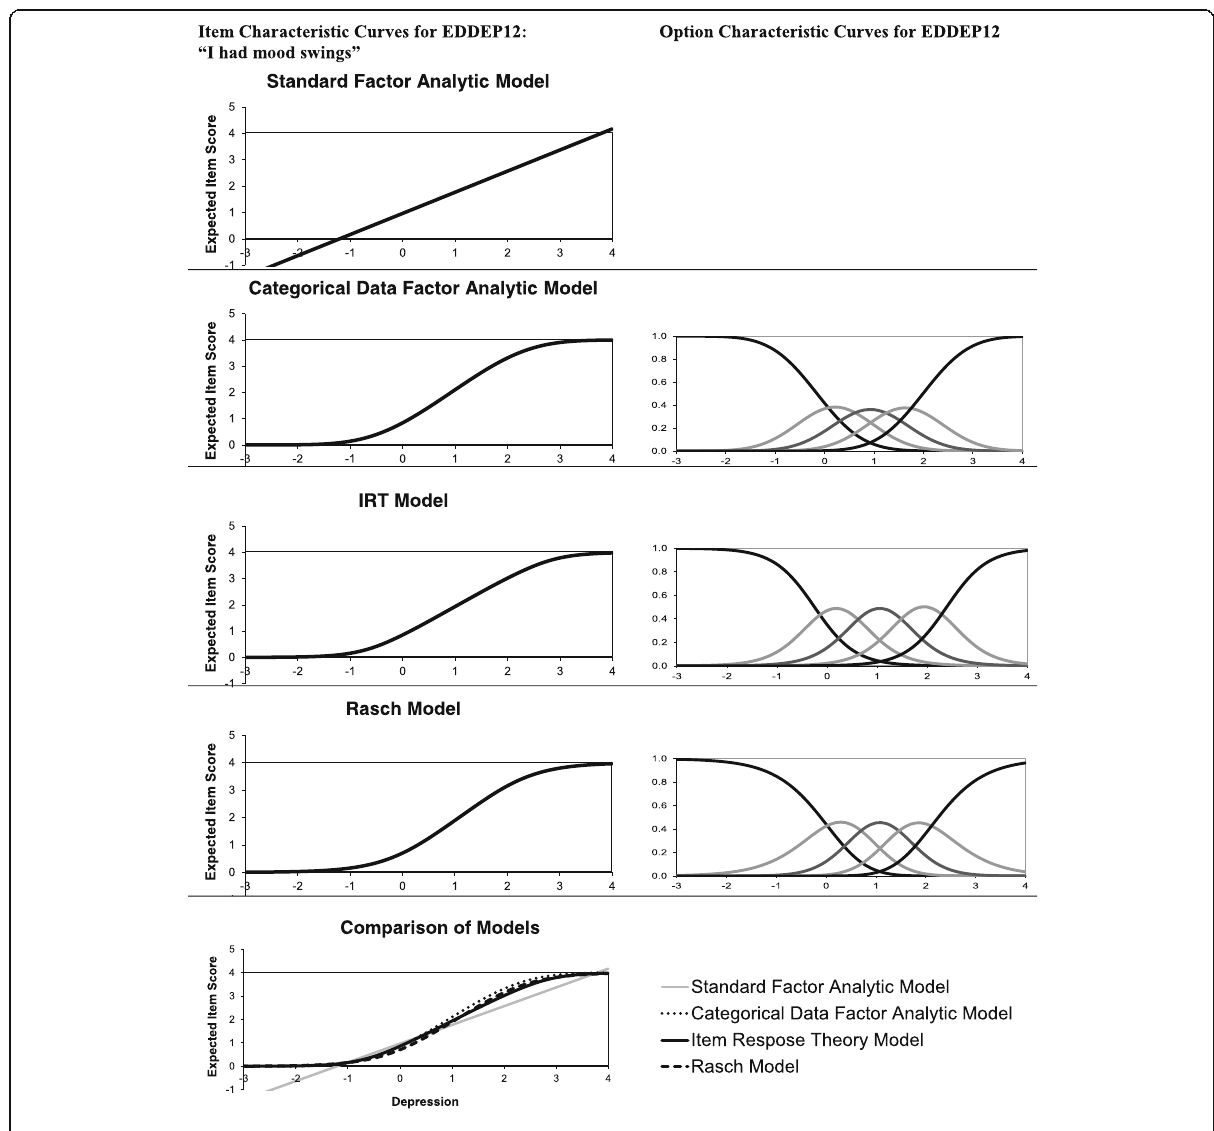
Fig. 1 Item characteristic curves and option characteristic curves for EDDEP12 “ I had mood swings ” according to standard and categorical data factor analytic models, item response theory models, and Rasch